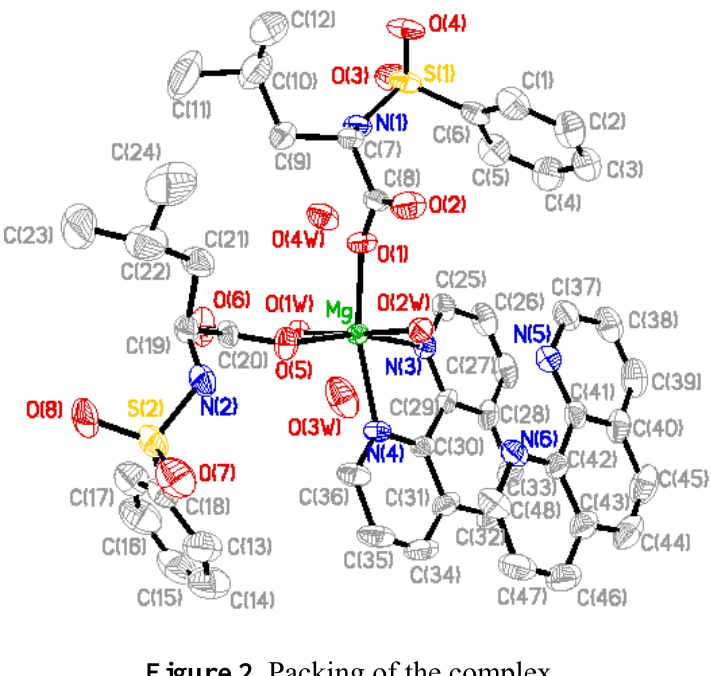
Figure 2. Packing of the complex.